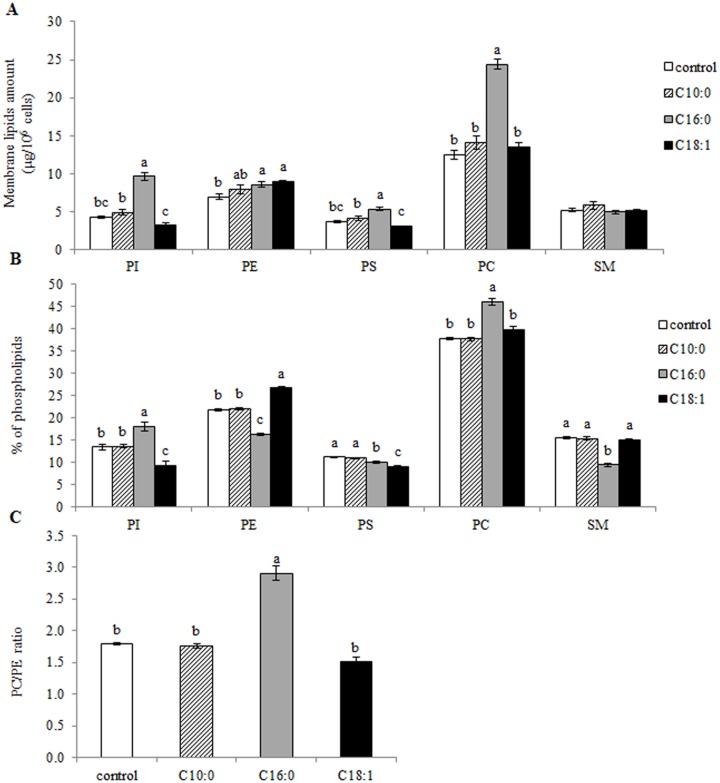
Specific free fatty acids (FFA) influence the amount and composition of phospholipid in mammary epithelial cells.Mammary epithelial cells were treated with 100 μM FFA (capric, palmitic or oleic acid) or with FFA-free medium (control) for 24 h; lipids were extracted and analyzed by HPLC-ELSD. (A) Membrane lipid amounts. (B) Phospholipid weight %. The percent of the amount of an individual phospholipid out of the summed phospholipids amounts. (C) Weight ratio between phosphatidylcholine and phosphatidylethanolamine. All data are presented as mean ± SEM. Different letters indicate significant differences between treatment groups (P < 0.05). PI: phosphatidylinositol; PE: phosphotidylethanolamine; PS: phosphatidylserine; PC: phosphotidylcholine; SM: sphingomyelin.